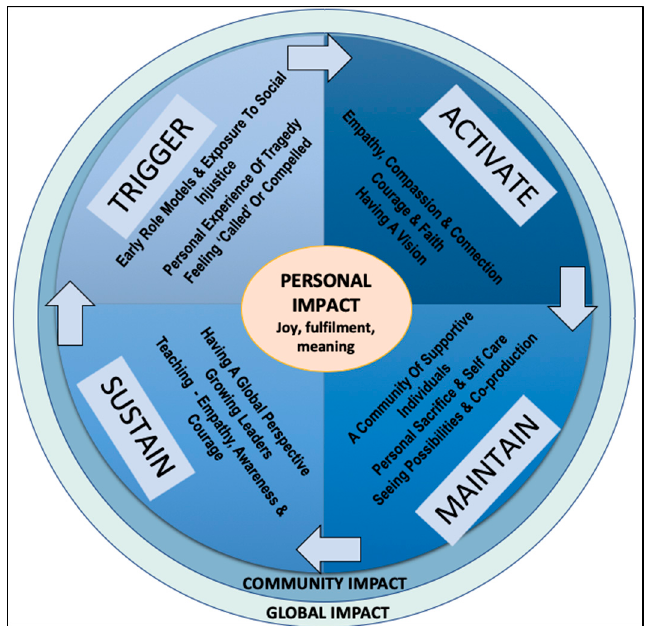
Figure 1. Self-transcendent social activism.